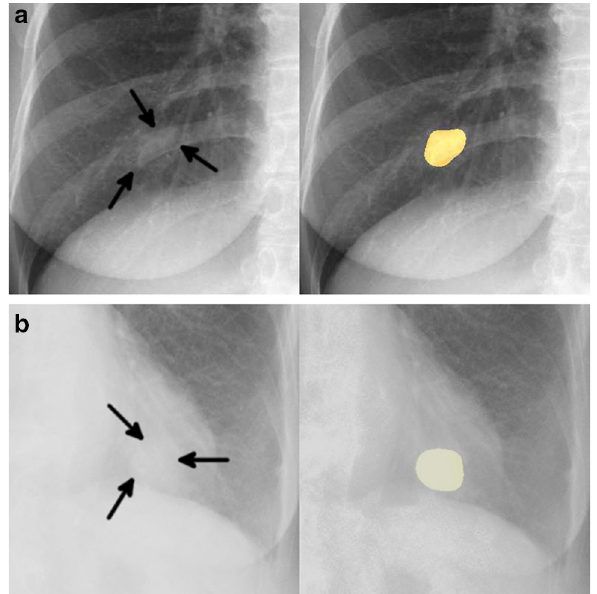
Figure 3. Two representative true positive cases. The images on the left are original images, and those on the right are images output by our model. ( a ) A 48-year-old woman with a nodule in the right lower lobe that was diagnosed as adenocarcinoma. The nodule was confused with rib and vessels (arrows). The model detected the nodule in the right middle lung field. ( b ) A 74-year-old woman with a nodule in the left lower lobe that was diagnosed as squamous cell carcinoma. The nodule overlapped with the heart (arrows). The lesion was identifiable by the model because its edges were traceable.